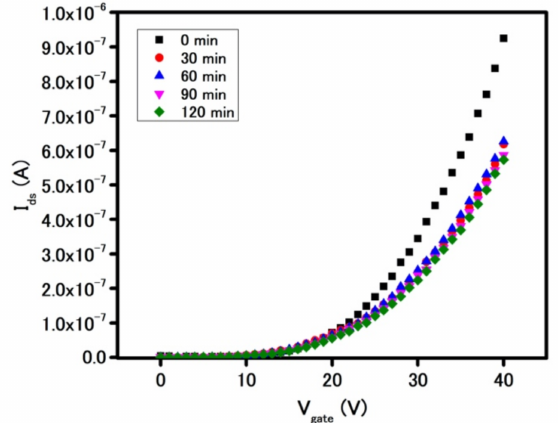
Figure 2. Stability of MoS 2 device in ambient air.